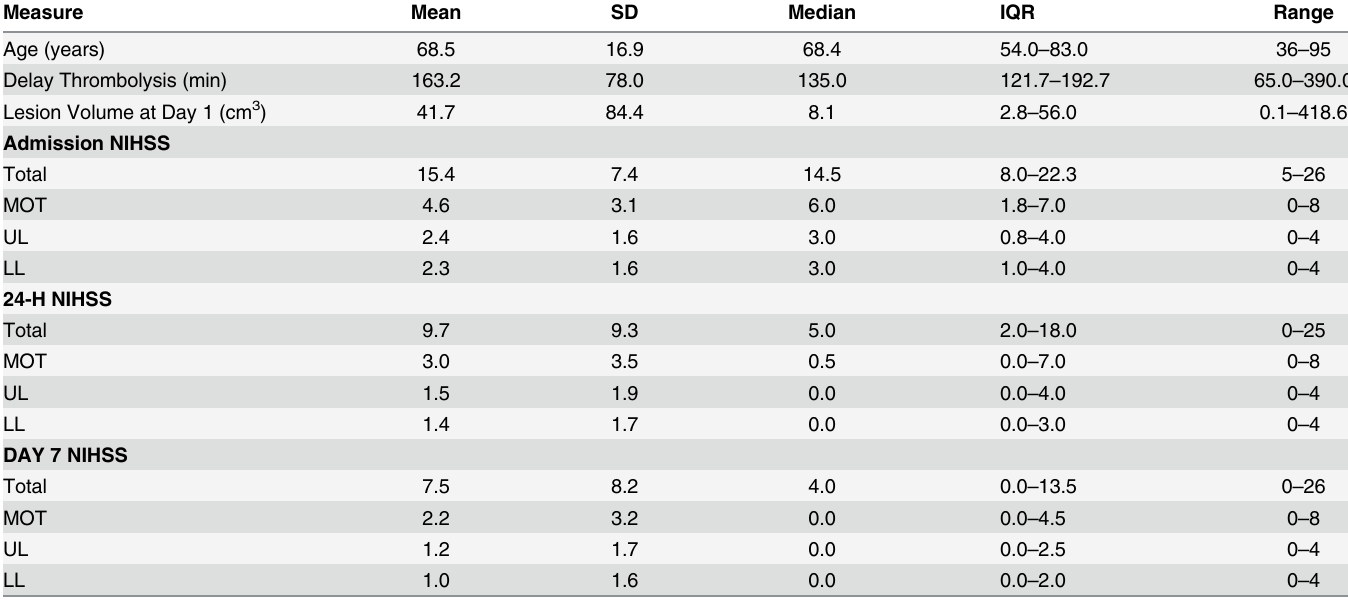
Table 1. Characteristics of the included patients.